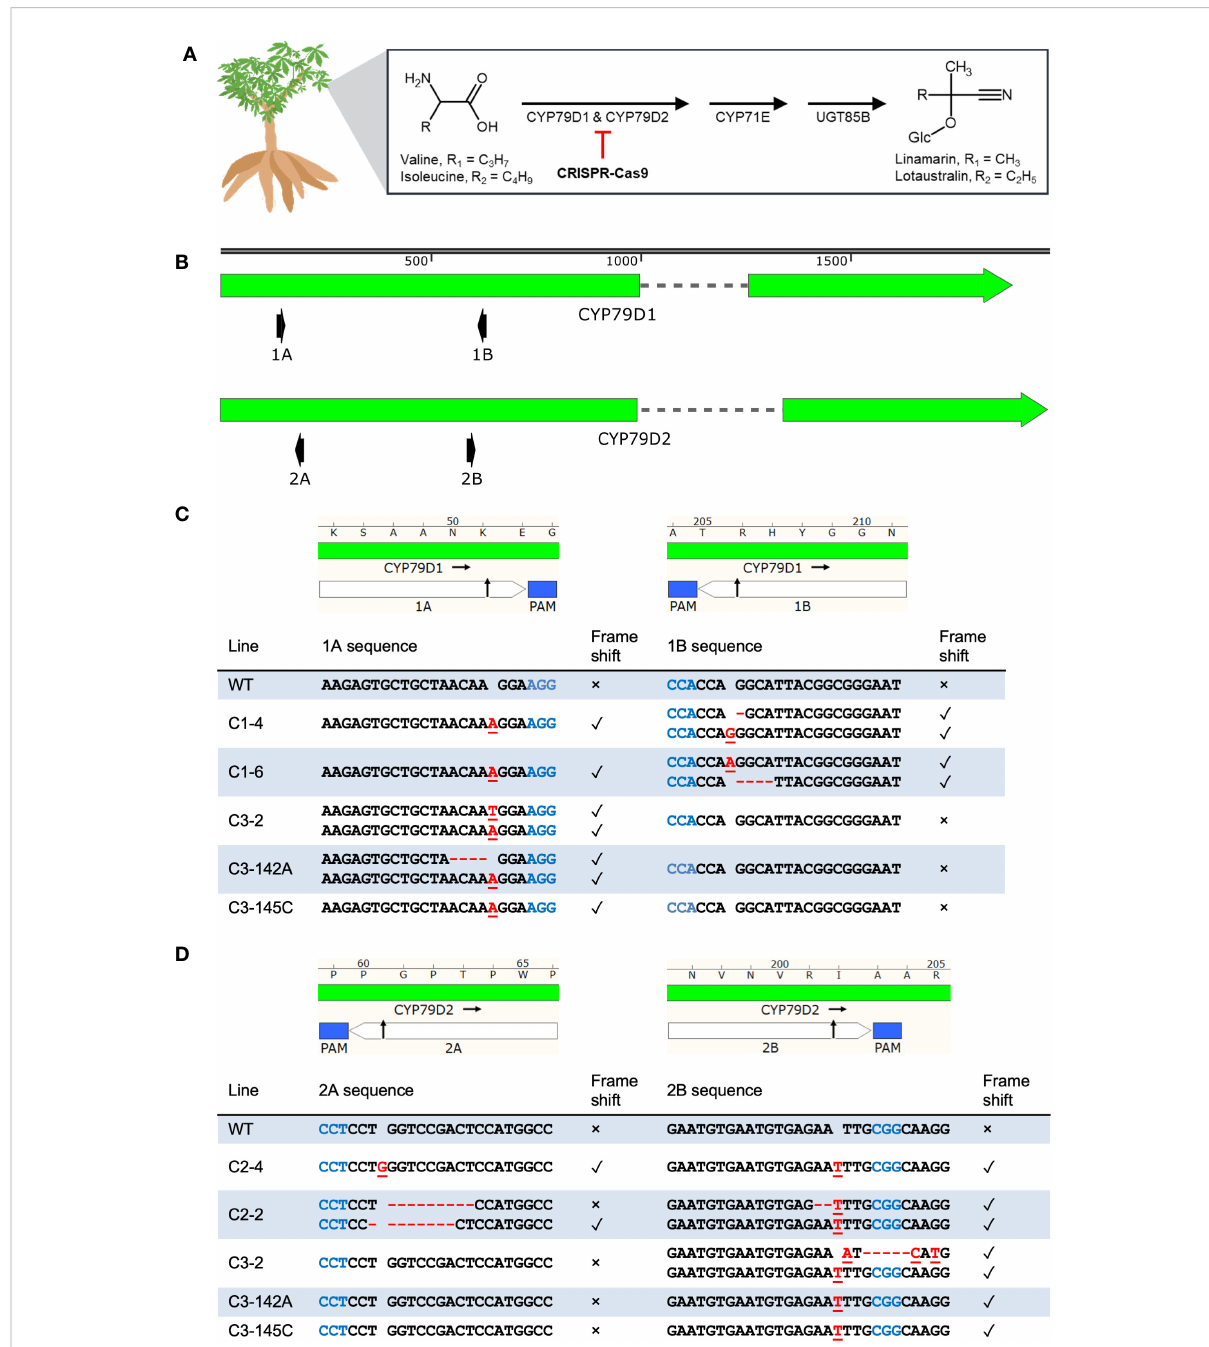
FIGURE 1 CRISPR-Cas9 induces indels at CYP79D1 and CYP79D2 gRNA target sites in transgenic 60444 lines. (A) Cassava biosynthetic pathway for the cyanogenic glucosides linamarin and lotaustralin. This process primarily occurs in the leaves. The step catalyzed by CYP79D1 and CYP79D2 enzymes was selected for disruption by the CRISPR-Cas9 system. Respective side chains are labeled as R1 and R2. Glc, glucose. Chemical structures created using ACD/Chemsketch ( “ ACD/Chemsketch, Version 2021.1.1 ” 2021). (B) Lengths of CYP79D1 and CYP79D2 genes are to nucleotide scale (top bar). Exons are denoted by solid blocks and introns are represented as dashed lines. Arrowheads indicate the 3 ′ terminus. Diagrams of the protospacers (white) and protospacer adjacent motifs (PAMs, blue) of CYP79D1 (C) and CYP79D2 (D) gRNA targets are aligned to edited line genotypes. Edited lines are identi fi ed by the CRISPR construct with which they were modi fi ed (C1, C2, C3), followed by an index number (e.g., 142A). Black arrow indicates predicted CRISPR-Cas9 cut site. Lengths are to amino acid (top bar) and nucleotide (bottom table) scale. Homozygous genotypes are shown as a single sequence per line. Bi-allelic genotypes are shown as two sequences per line. Mutations on the same haplotype at 1A and 1B sites in a given mutant line are shown in the same row. Insertions are denoted by red, underlined nucleotides. Deletions are denoted by red dashes. Presence of a frameshift mutation at the corresponding target site is denoted by ✓ ; absence of a frameshift mutation is denoted by ×. WT, wildtype. Maps created with